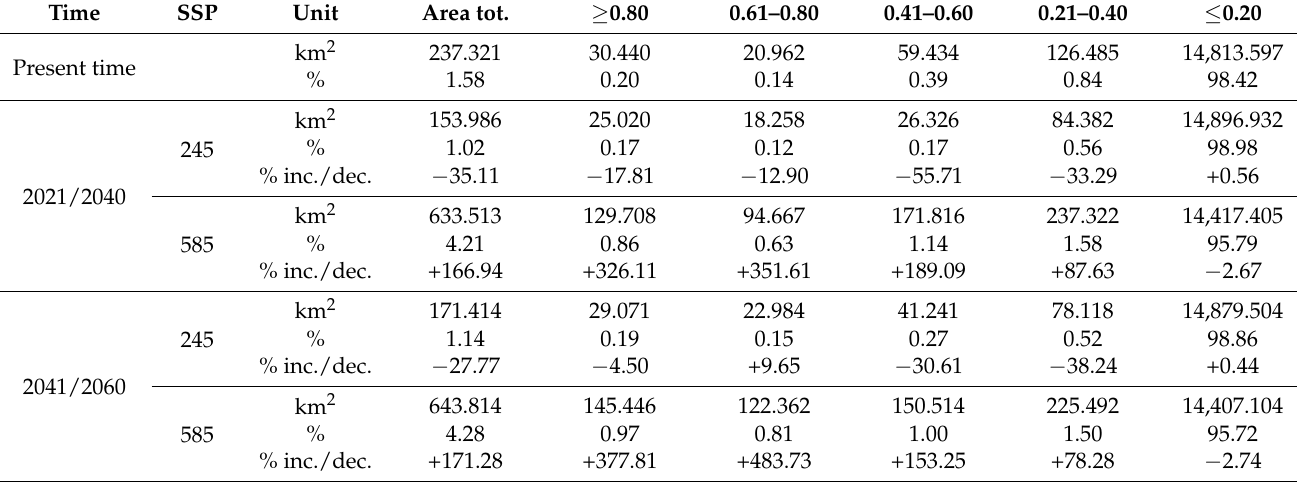
Table 3. Classification of habitat suitability in relation to the probability values for the presence of Salvia ceratophylloides Ard. (highly unsuitable ( ≤ 0.20); unsuitable (0.21–0.40); moderately suitable